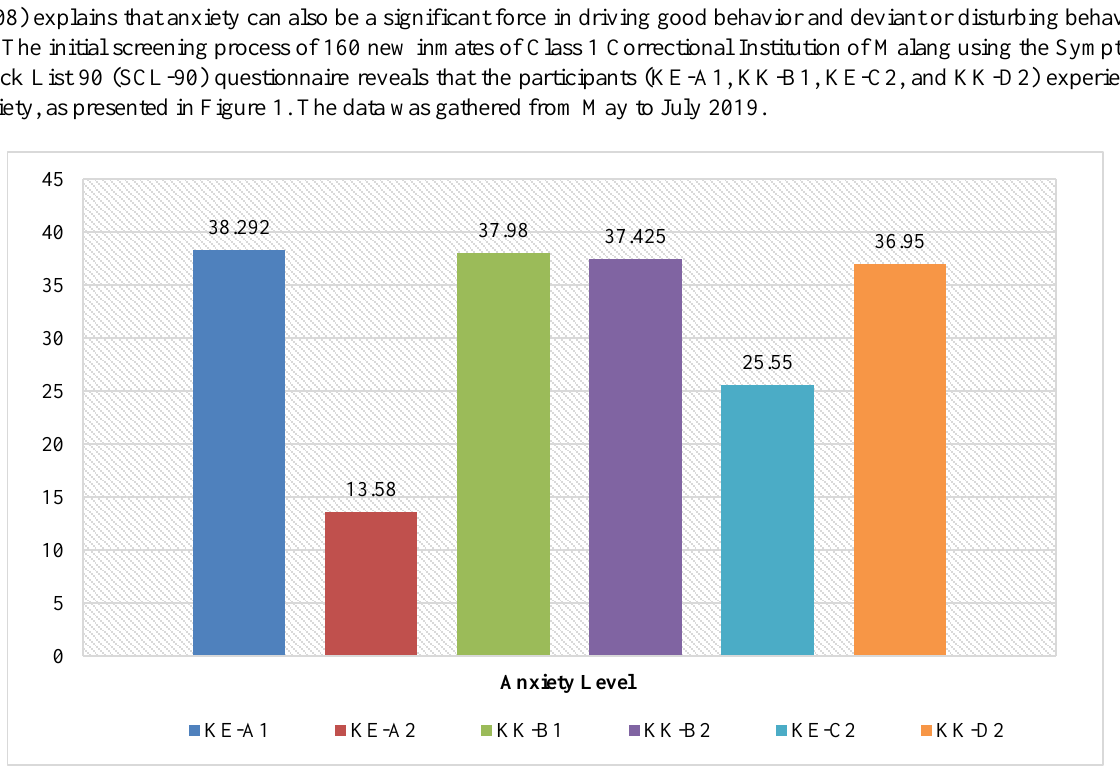
Figure 1. Description of Average ( 𝑿̅ ) Anxiety Levels of KE and